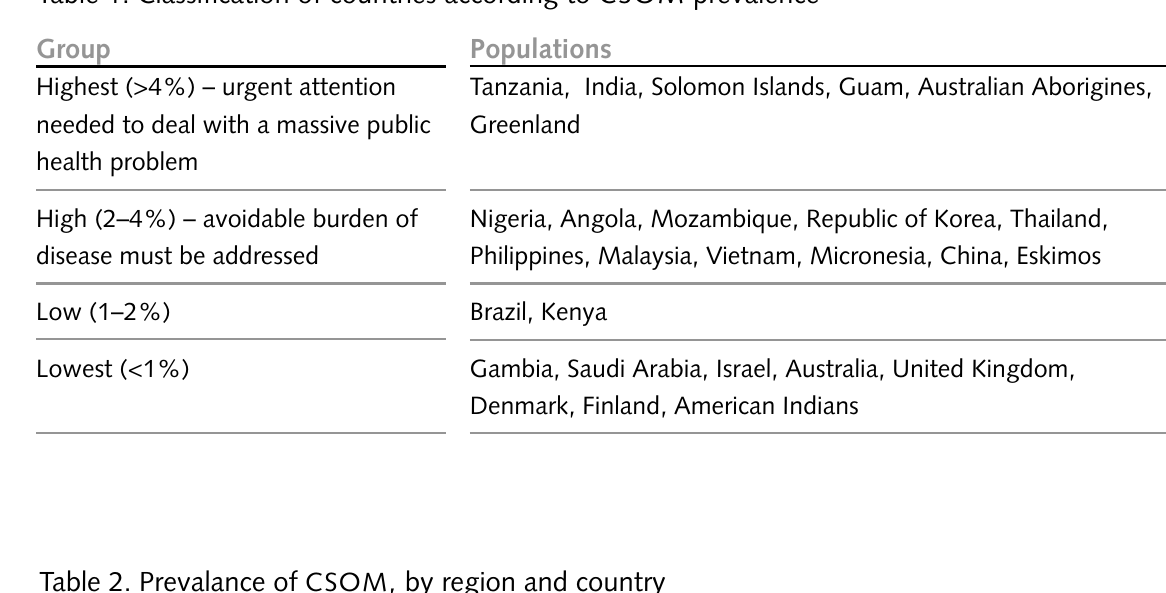
Table 2. Prevalance of CSOM, by region and country Region/Country